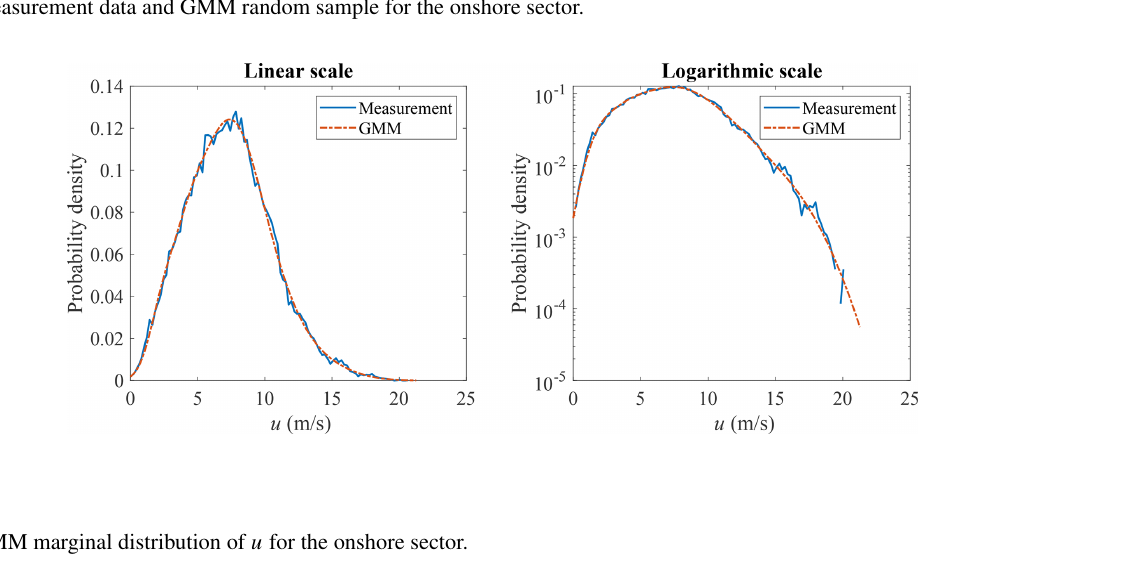
Figure 15. Measurement data and GMM random sample for the onshore sector.